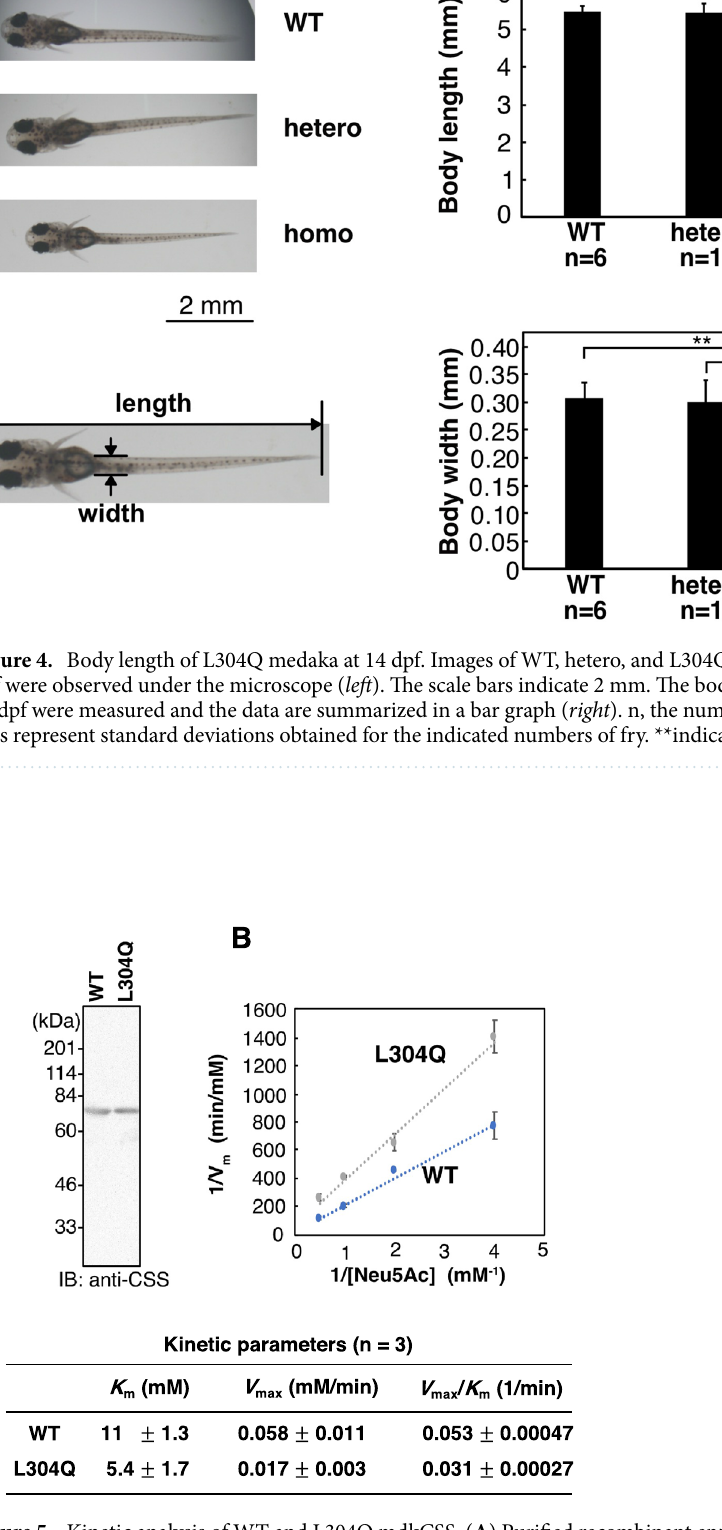
Figure 5. Kinetic analysis of WT and L304Q mdkCSS. ( A ) Purified recombinant enzymes used for the kinetic analysis. SDS-PAGE/CBB staining ( left ). Western blotting using the anti-mdkCSS antibodies ( right ). Full-length blots for A are presented in Supp_FigS11. ( B ) Lineweaver–Burk plots for the synthesis of CMP-Neu5Ac by mdkCSSs. ( C ) Kinetic parameters. K m , V max , and V max / K m values are expressed as average values ± standard deviations from three independent experiments (n =